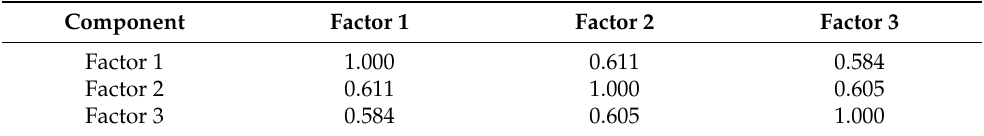
Table 4. Component correlation matrix between the principal component analysis and Promax rotation with Kaiser